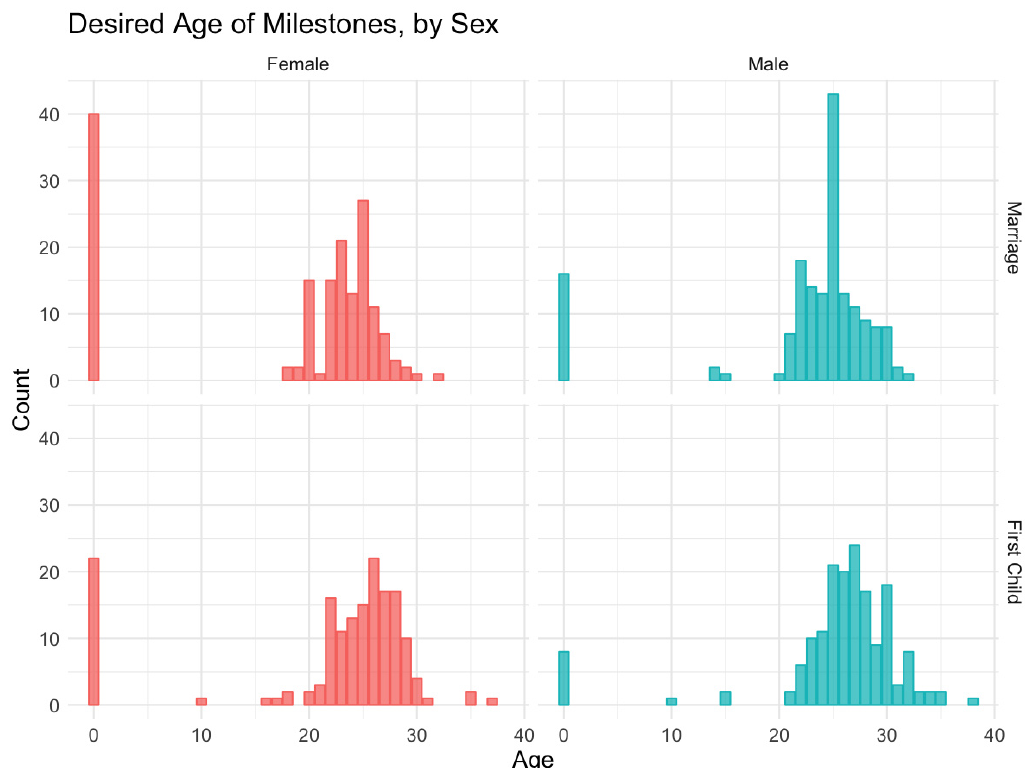
Figure 3. Desired age at marriage and first child milestones, by gender of respondent. The bars at age 0 indicate those who did not wish to fulfill that milestone.